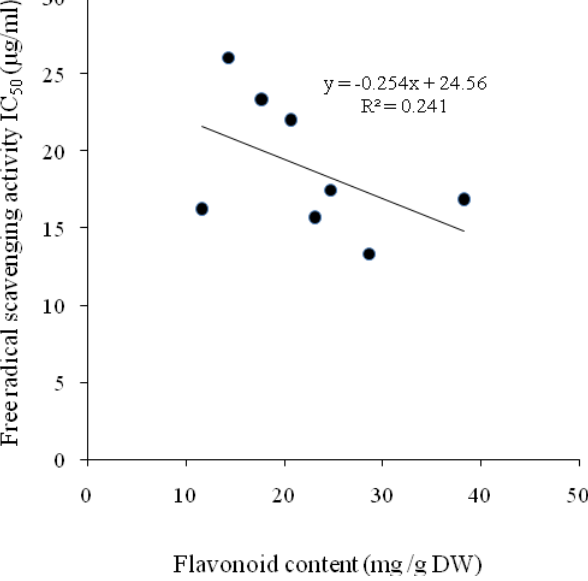
Fig. 3. Correlation of free radical scavenging activity (Y) versus flavonoid content (X) of eight Lamiaceae plants of